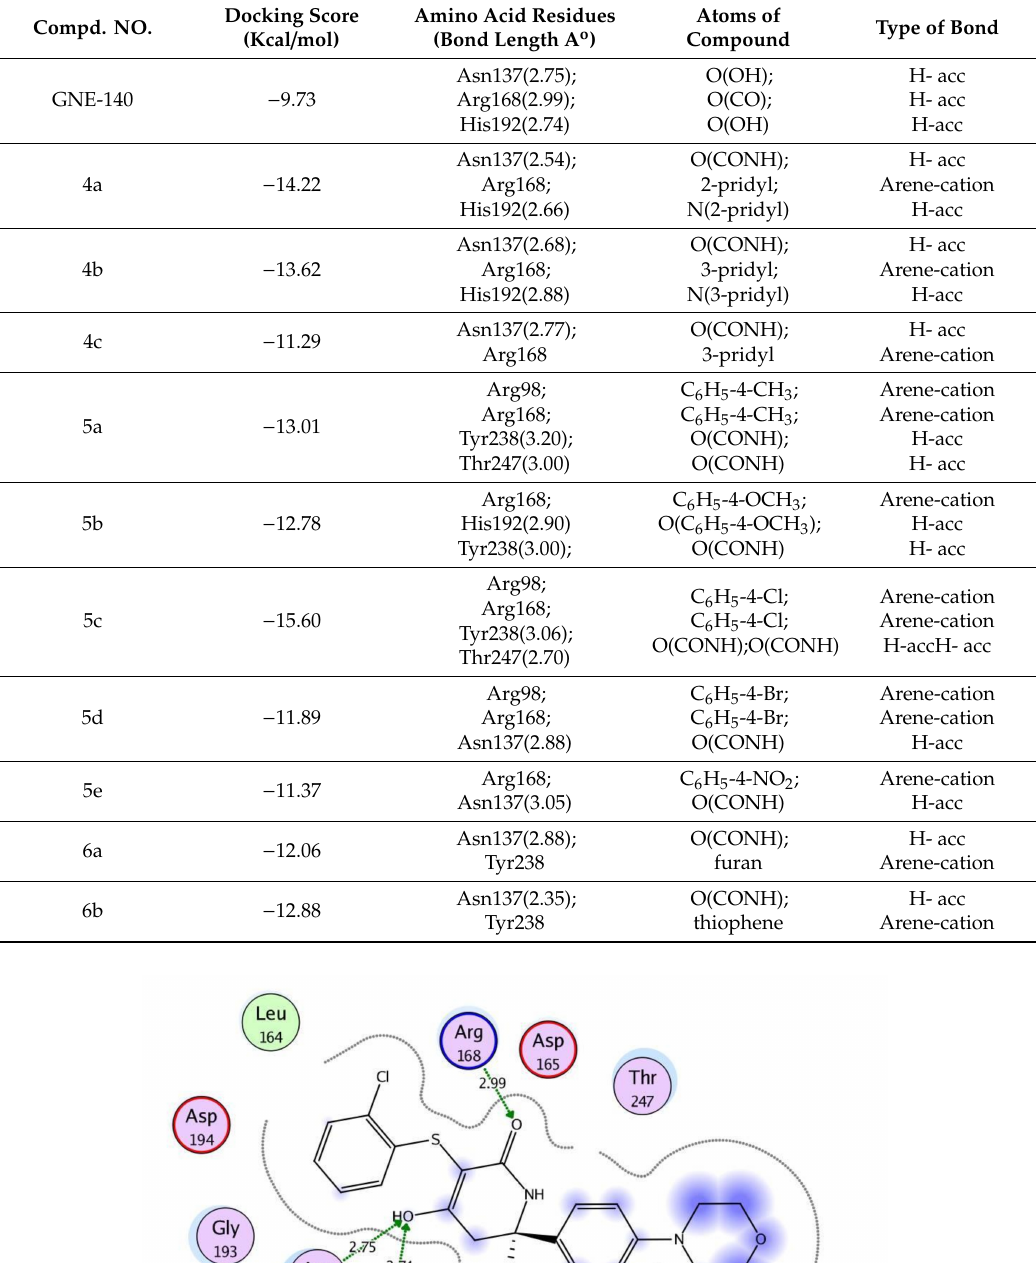
Table 1. Molecular docking data of the synthesized compounds 4 – 6 in comparison with GNE-140 within the active site of LDHA kinase using MOE software version 2008.10. Compd.